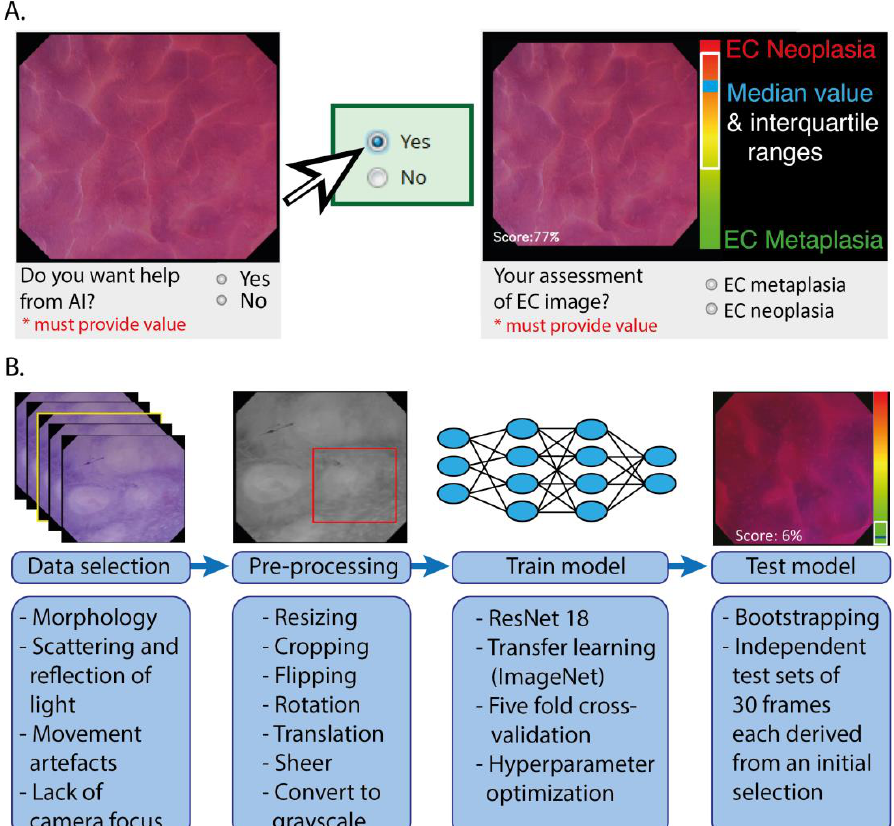
Figure 3. Overview of the display and the formation of the output of the CNN architecture. ( A ) After a request, AI assistance was presented as a score on a continuous scale (0 – 100), which was the average score of all five models in the ensemble. ( B ) To develop a CNN architecture for the interpretation of endocytoscopic BE images, we trained and tested in distinct image sets of preprocessed images that were selected from the prospectively acquired